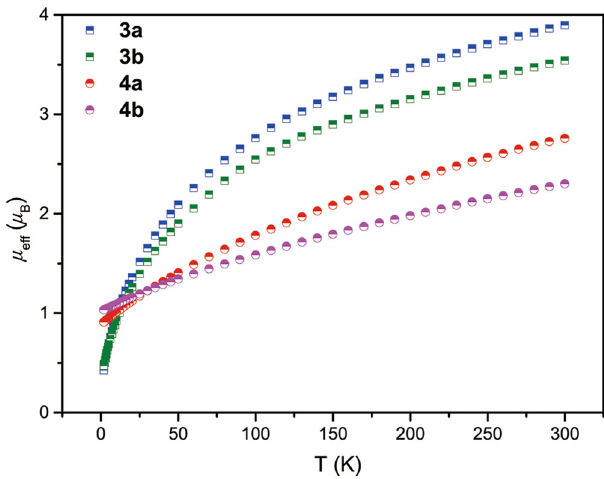
Fig. 5 Magnetic data. Variable-temperature effective magnetic moment data of 3a (blue), 3b (green), 4a (red) and 4b